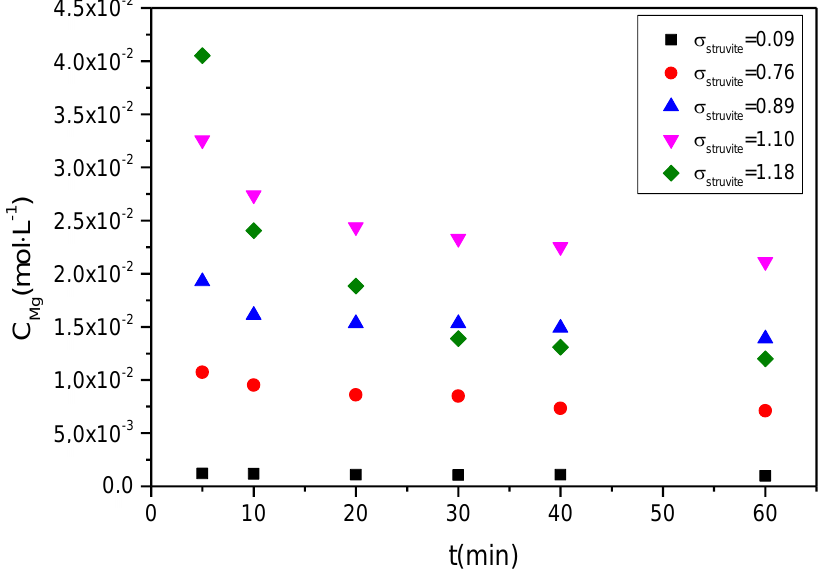
Figure 10. Precipitation of struvite from supersaturated synthetic wastewater. Magnesium concen- tration, C Mg as a function of time. Initial pH ca. 9.50 (Table 4); 25 °C.